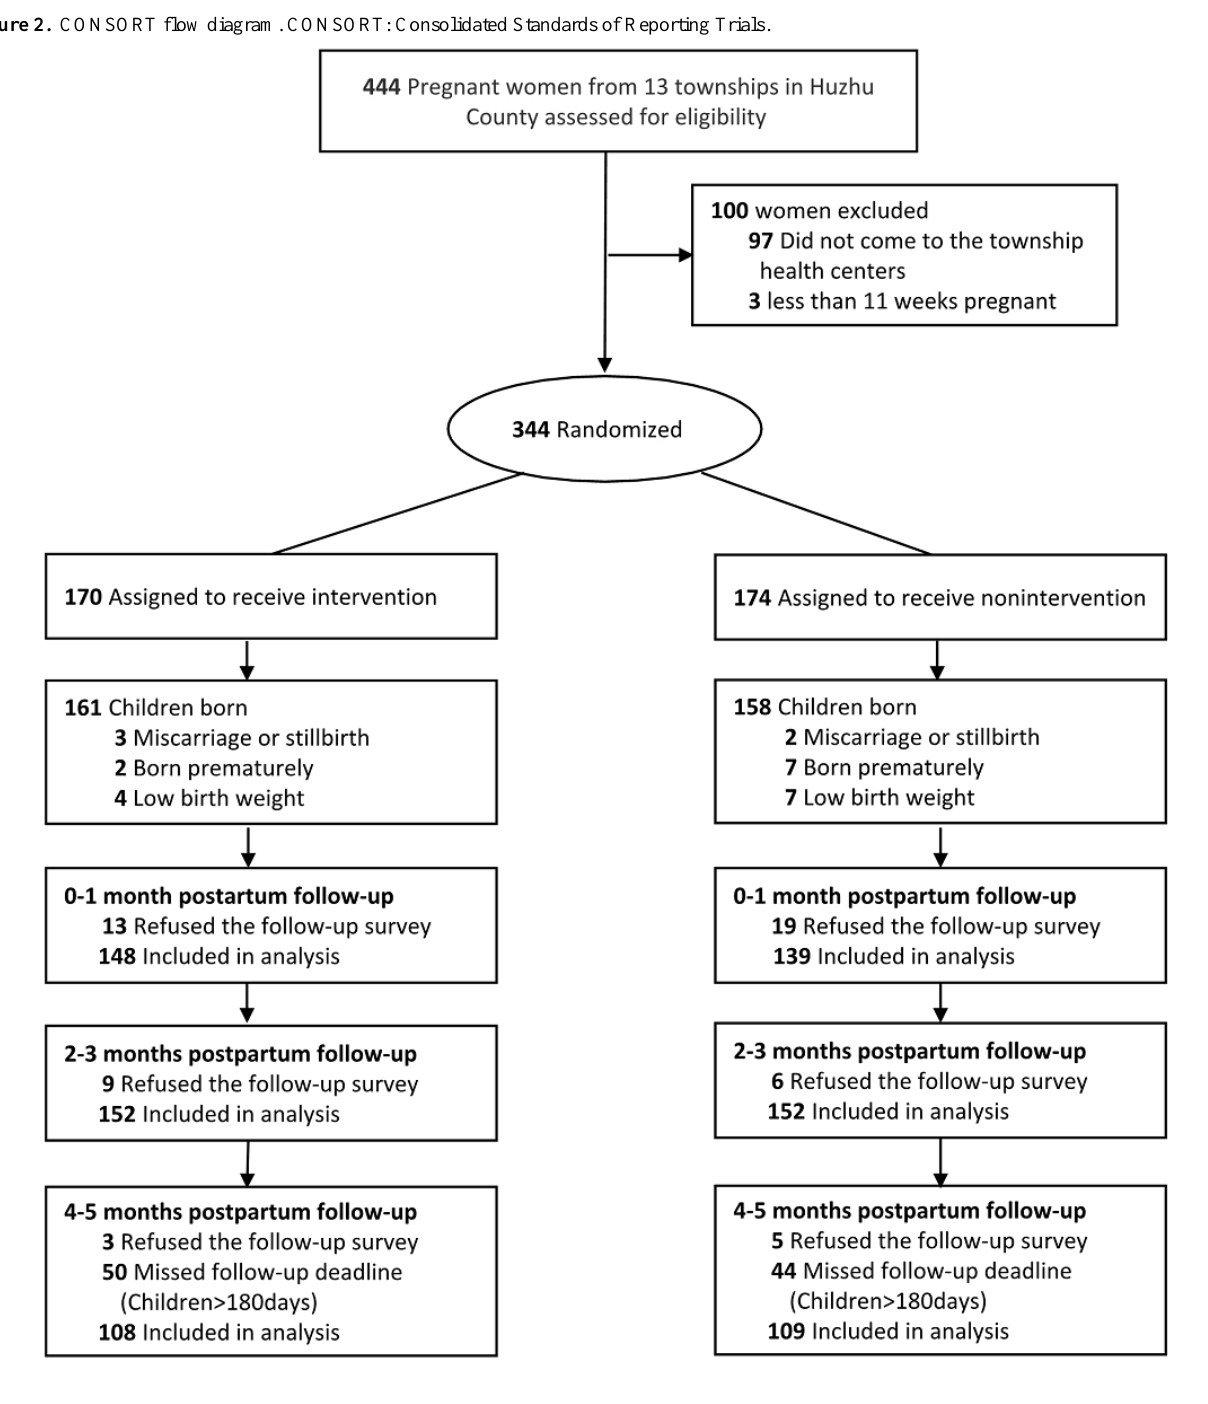
Figure 2. CONSORT flow diagram. CONSORT: Consolidated Standards of Reporting